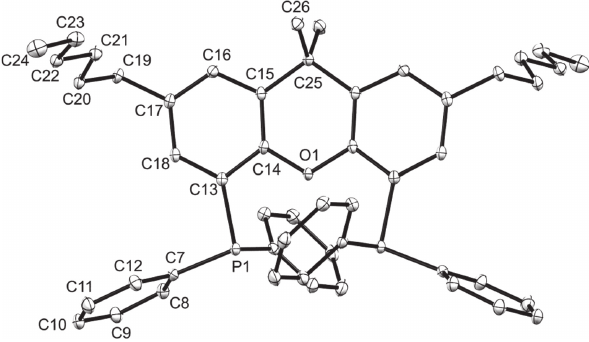
Table 1: Data collection and handling.